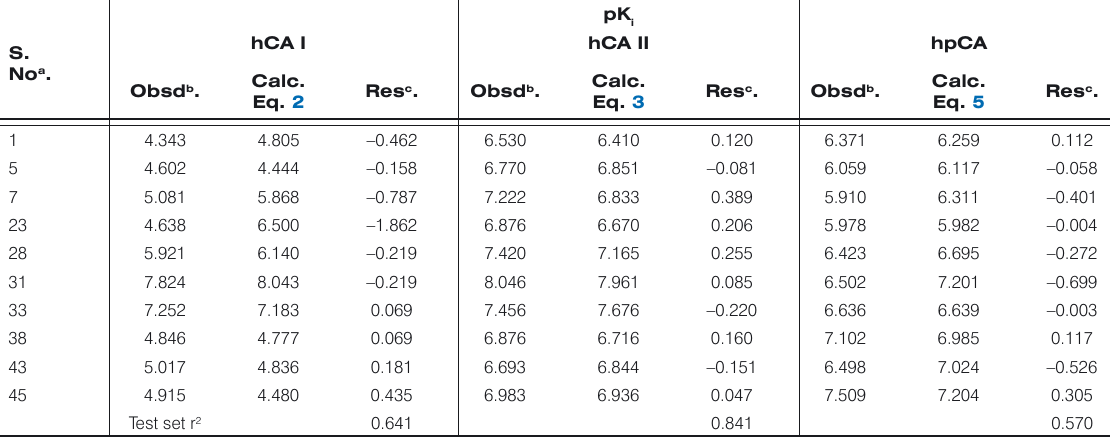
Table 2. Predicted residual activity of test set compounds and corresponding predictive r 2